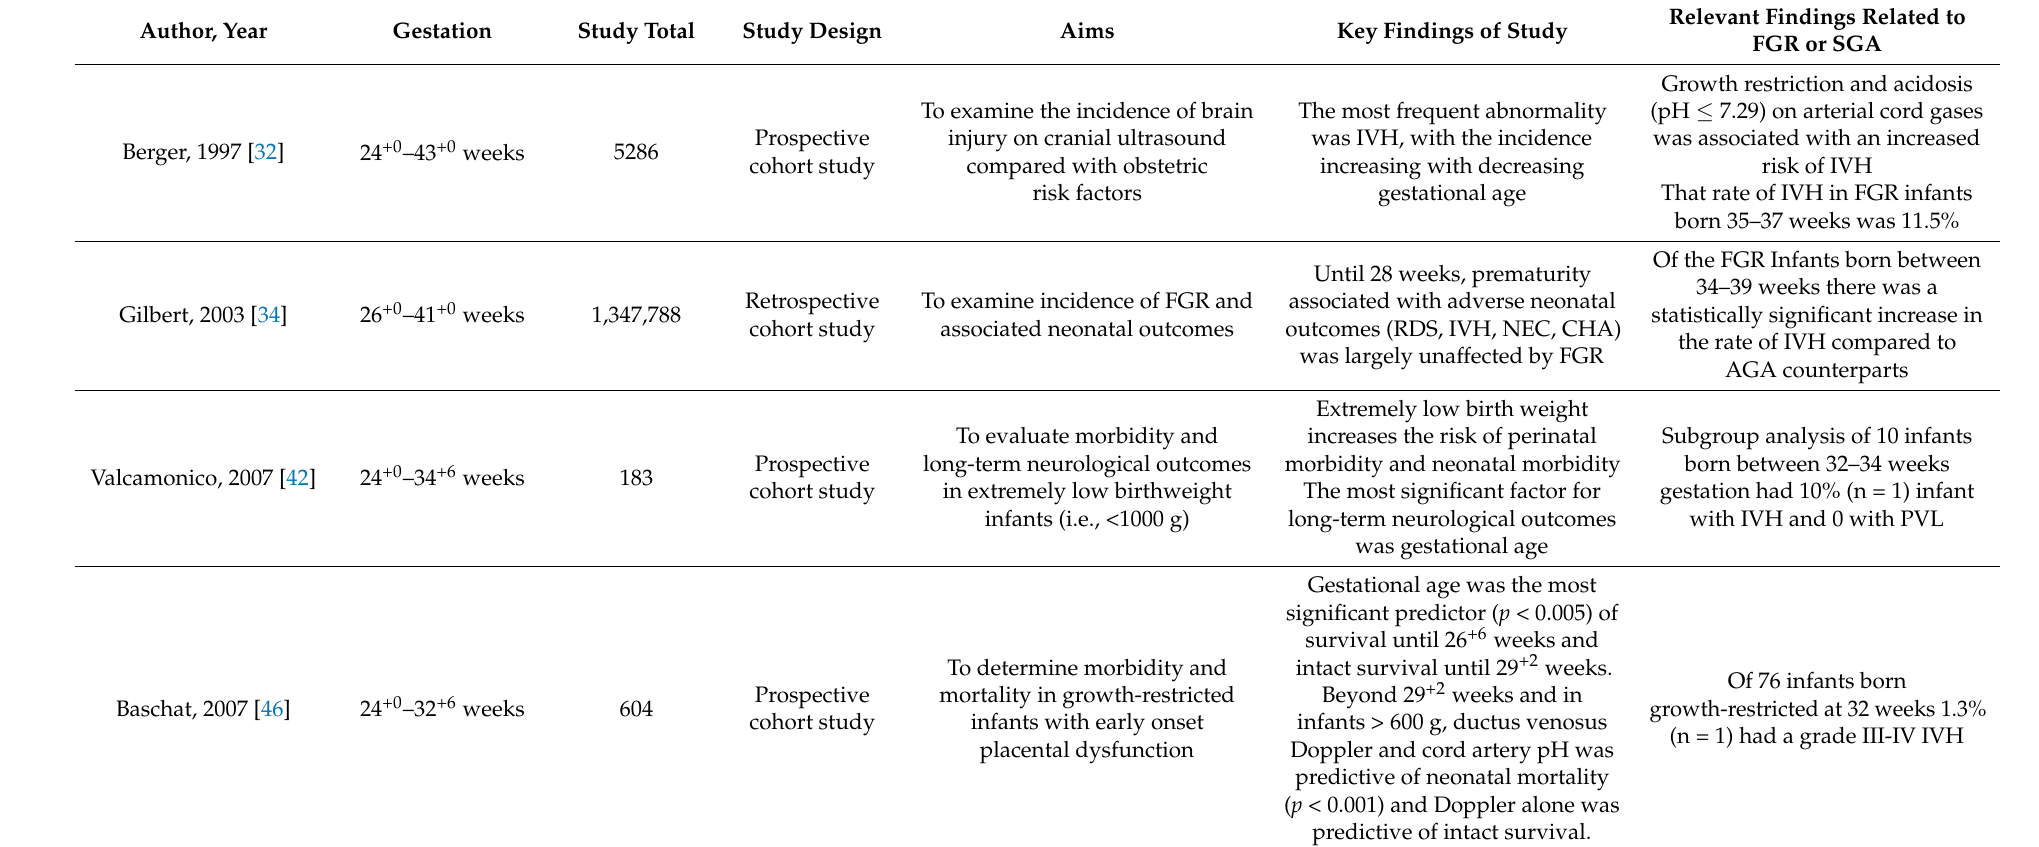
Table 3. Studies including cranial ultrasonography abnormalities in moderate-late preterm growth-restricted and SGA